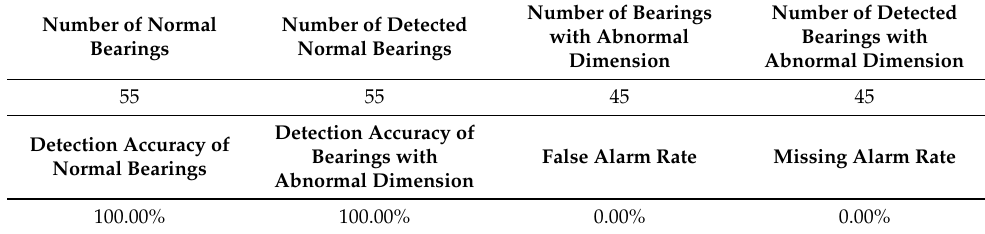
Table 3. Detection results of abnormal dimension.